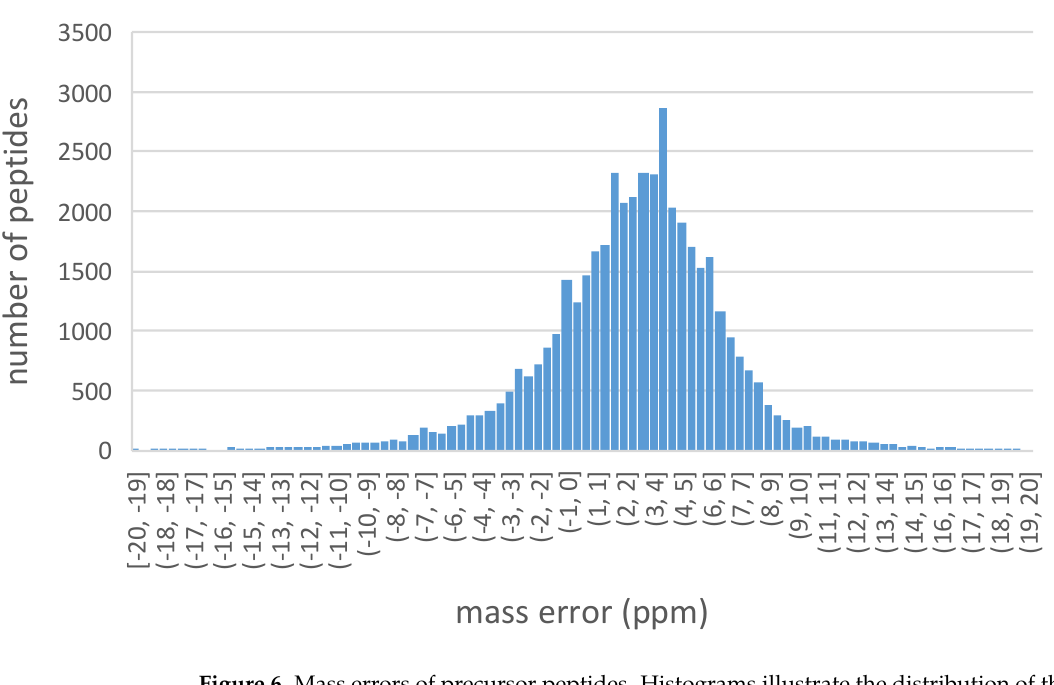
Figure 5. Comparison of ( a ) median FWHM and ( b ) peptide peak capacity among five gradient types. The median FWHM was calculated based on all peptides (with a minimum intensity of 2500) using MaxQuant (version 2.0.3.1). Peptide peak capacity was calculated by dividing the run time by the median FWHM. Ion chromatograms are shown in Figures S1 – S12.